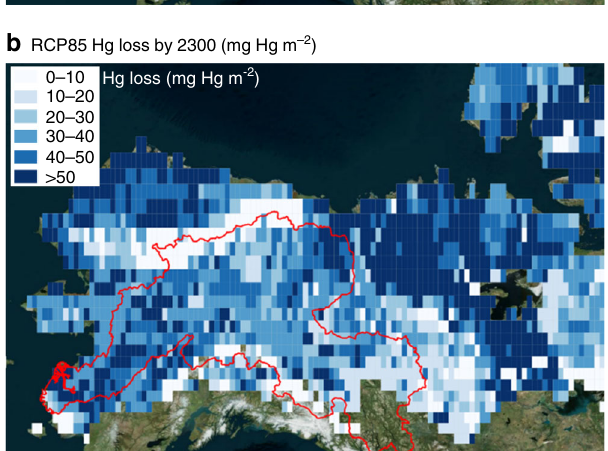
Fig. 3 Cumulative mercury (Hg) loss per area by 2300. Total Hg loss is net elemental mercury (Hg 0 ) fl ux to the atmosphere plus mercury cation (Hg II ) export by rivers summed from 1901 to 2300. The red outline indicates the spatial extent of the Yukon River